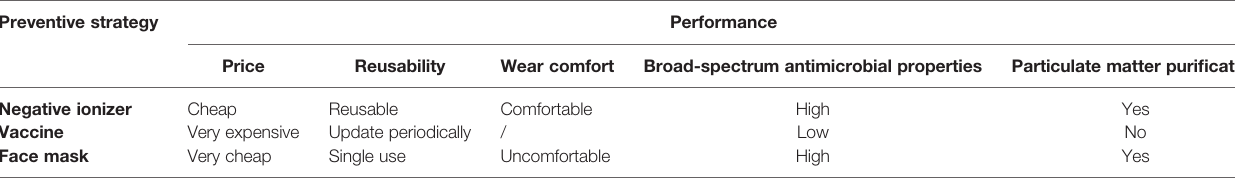
TABLE 1 | Performance comparison of different preventive